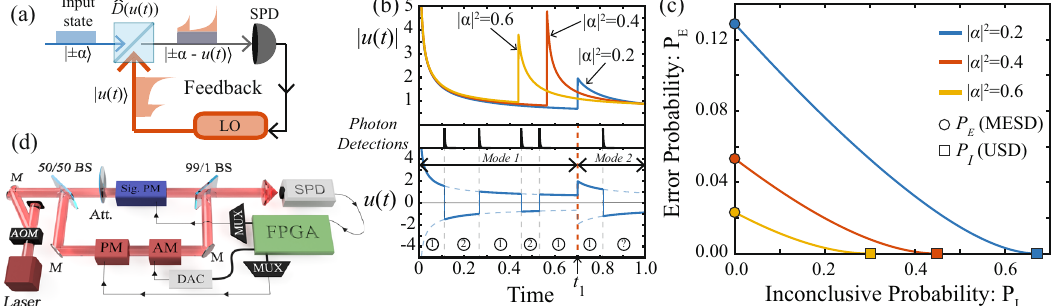
Fig. 1 Implementation of the optimal inconclusive measurement. a Schematic of the generalized receiver for the optimal inconclusive measurement. The input states are displaced in phase space using an optimal waveform u ( t ) for the LO fi eld and followed by a single-photon detector (SPD) and feedback operations. b Optimal waveform magnitudes ∣ u ( t ) ∣ for different mean photon numbers | α | 2 (top panel). The bottom panel shows an example of the waveform u ( t ) for a particular measurement record where the LO phase switches between 0 and π every photon detection (Photon Detections, middle panel). The circles along the x -axis show the current hypothesis for the input state as the measurement progresses. c Error probability P E for the optimal inconclusive measurement as a function of the speci fi ed probability of inconclusive results P I for ∣ α ∣ 2 = 0.2, 0.4, and 0.6. The colored circles along the y -axis ( P I = 0) correspond to the smallest possible P E in the paradigm of MESD, and the colored squares along the x -axis ( P E = 0) correspond to the smallest possible P I in the paradigm of USD. d Experimental setup used for demonstrating the optimal inconclusive measurements of binary coherent